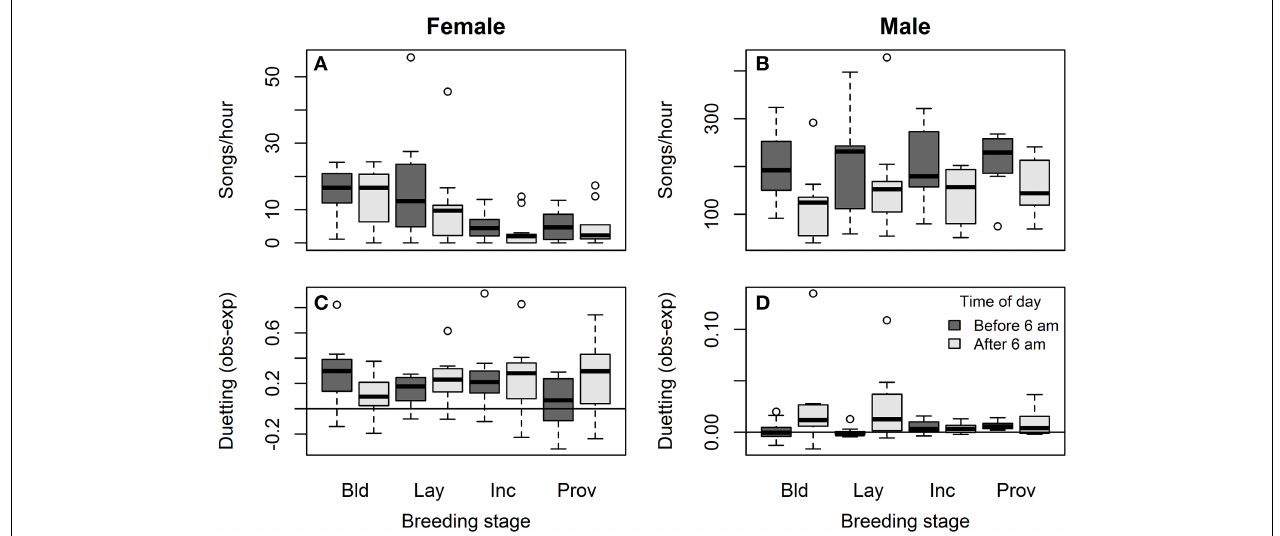
FIGURE 2 | Breeding stage and diurnal variation in female and male song. Variation in song rate associated with different stages of the breeding cycle (nest-building, egg-laying, incubation, and provisioning of nestlings or fledglings) and time of day (dark bars = before 6 a.m., light bars = after 6 a.m.) in (A) females and (B) males – note the 10-fold difference in scale of the y-axis between the sexes. Variation in the probability of answering song associated with different stages of the breeding cycle and time of day in (C)